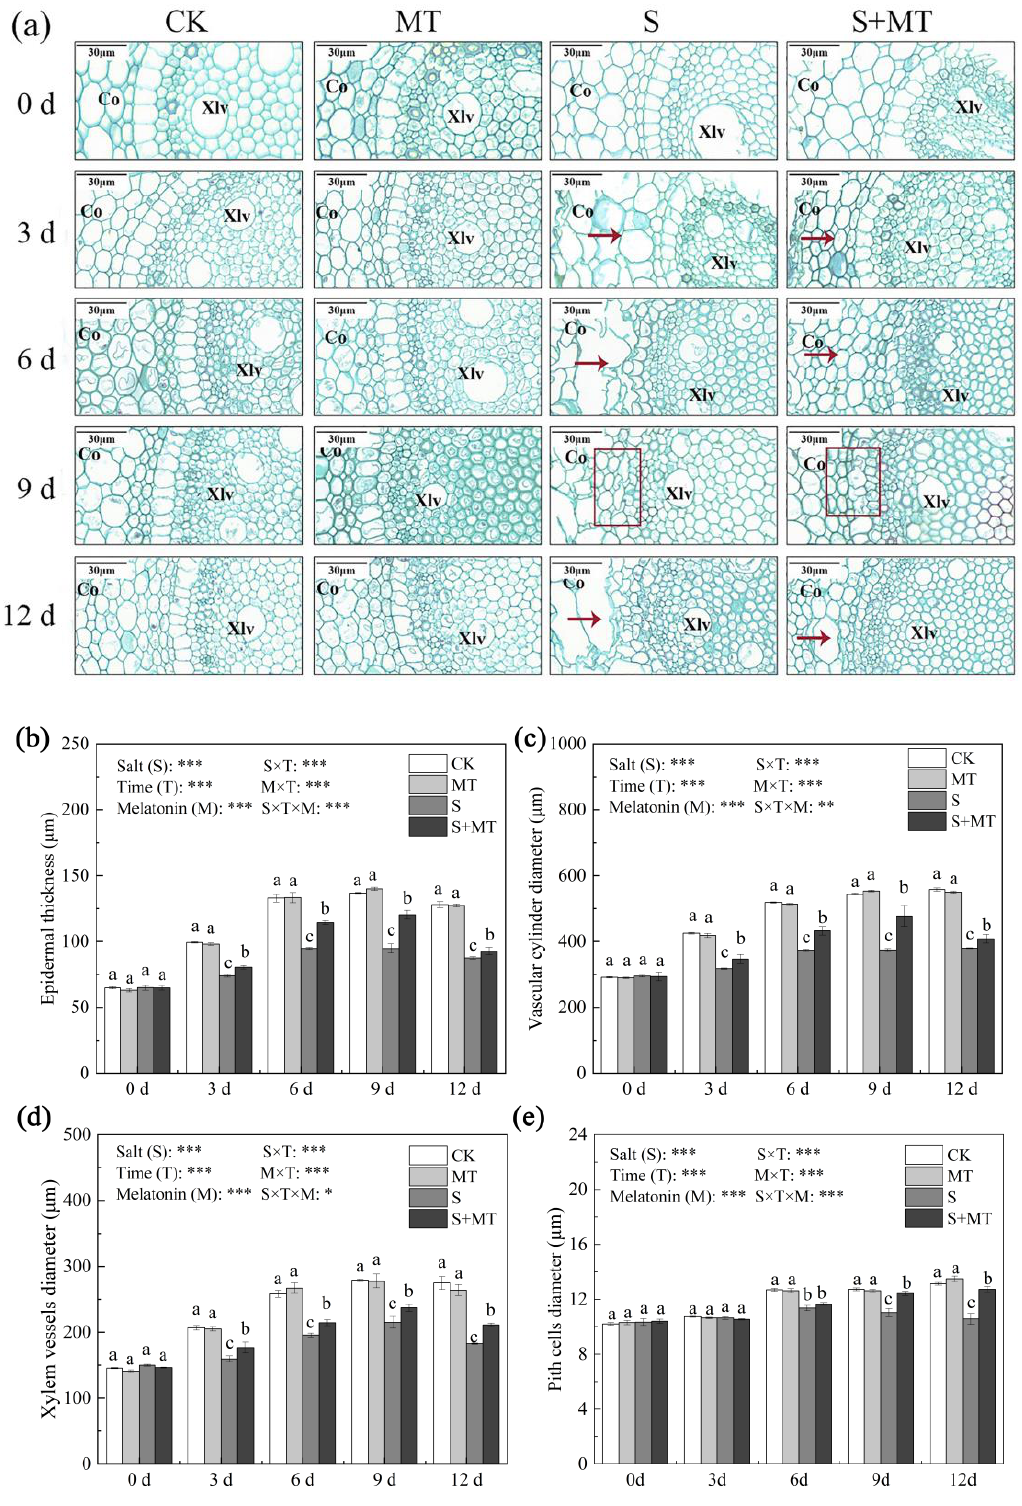
Figure 5. Effect of the exogenous application of melatonin on the root tissue of C. leucochlora seedlings under salt stress. ( a ) Partial transverse section of the root anatomy; bar charts of ( b ) epidermal thickness; ( c ) vascular cylinder diameter; ( d ) xylem vessel diameter; ( e ) pith cell diameter. co = cortex; xly = xylem vessel. The error bars represent the standard deviation. Significance levels are presented for each main effect or interaction. *** p < 0.001; ** p < 0.01; * p < 0.05.